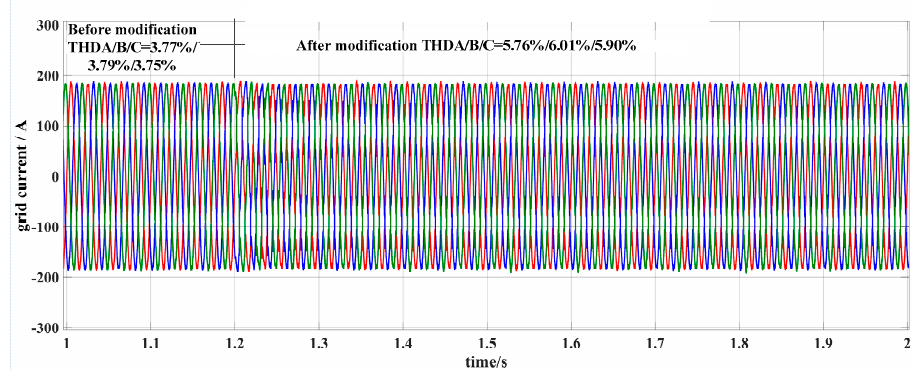
Figure 20. Simulated grid current i sys when shunt APF is compensating for RL load and rectifier load.